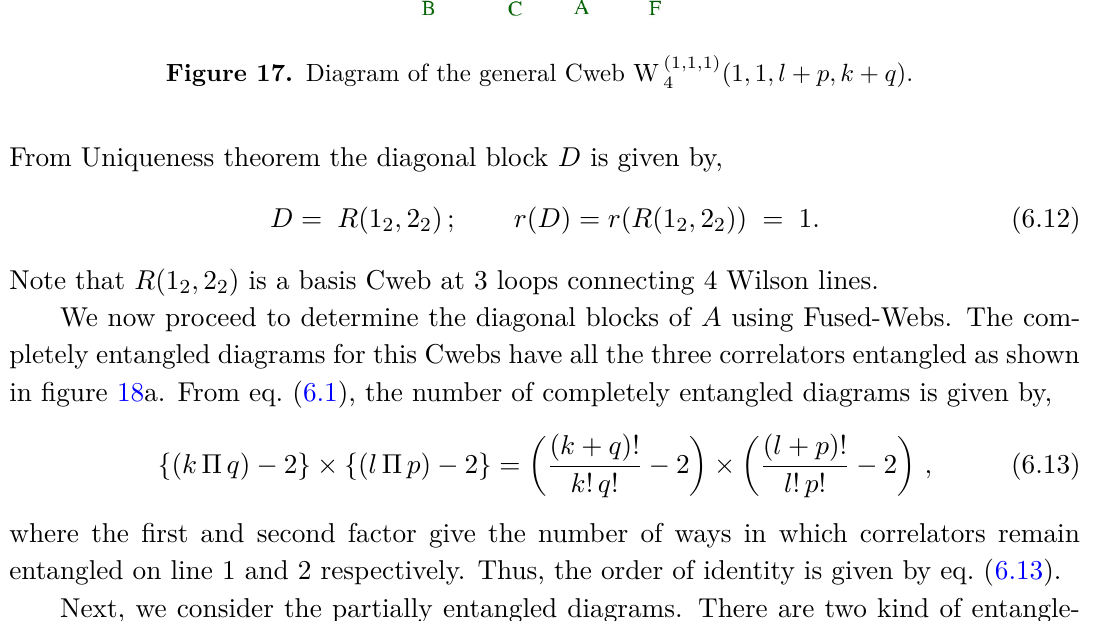
Figure 17. Diagram of the general Cweb W (1 , 1 , 1)